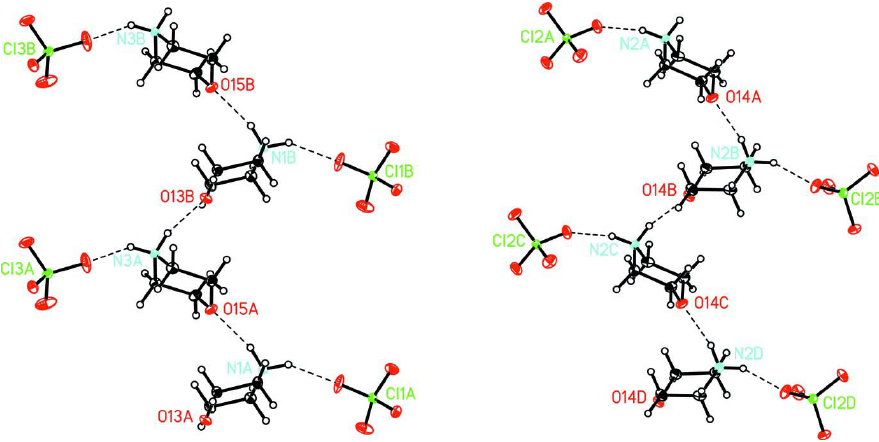
Figure 3 The comparison of two different types of